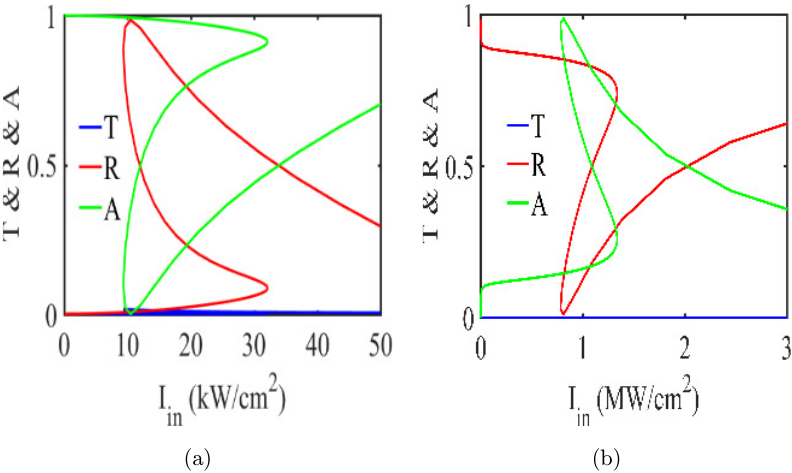
Fig. 7. The nonlinear performance of structure EGBCBC: (a) at (cid:6) ¼ 1120 nm with structure parameters n prism ¼ n b ¼ 3 : 48, Fig. 6(a). The nonlinear refractive index of layer C is n c 2 ¼ 2 : 5 (cid:5) 10 (cid:3) 15 m 2 /W in both calculations.